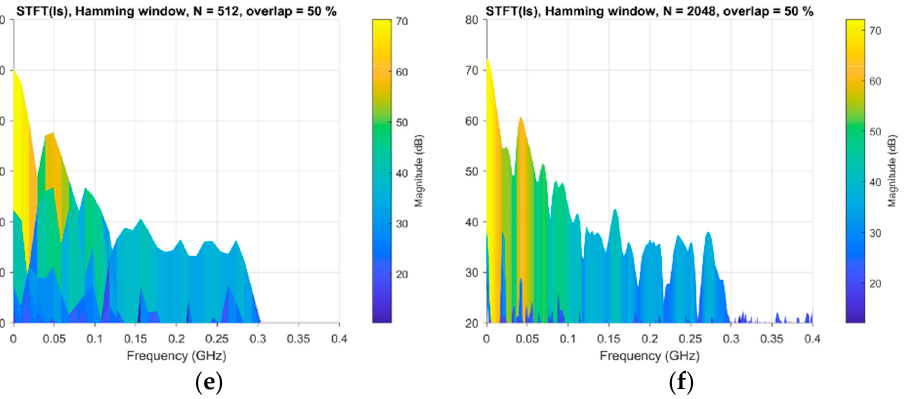
Figure 8. STFT analysis comparison for several windows and window lengths: ( a ) flat top window 𝑁 = 512 ; ( b ) flat top window 𝑁 = 2048 ; ( c ) rectangular window 𝑁 = 512 ; ( d ) rectangular window 𝑁 = 2048 ; ( e ) Hamming window 𝑁 = 512 ; ( f ) Hamming window 𝑁 = 2048 .